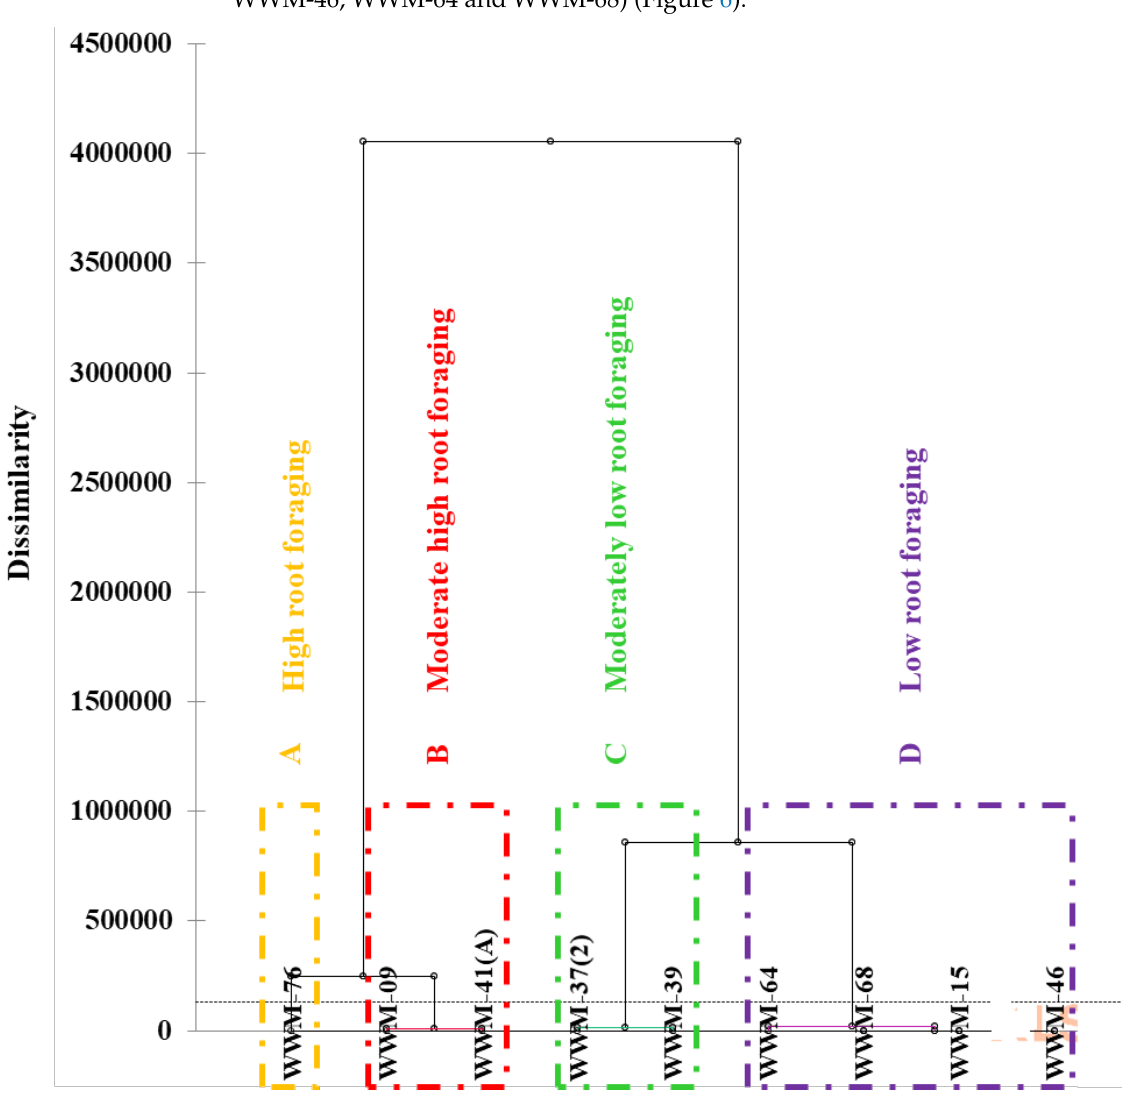
Figure 6. Dendrogram distinguishing the levels of root foraging among nine citron watermelon accessions based on measured root system architecture traits under water stress conditions.